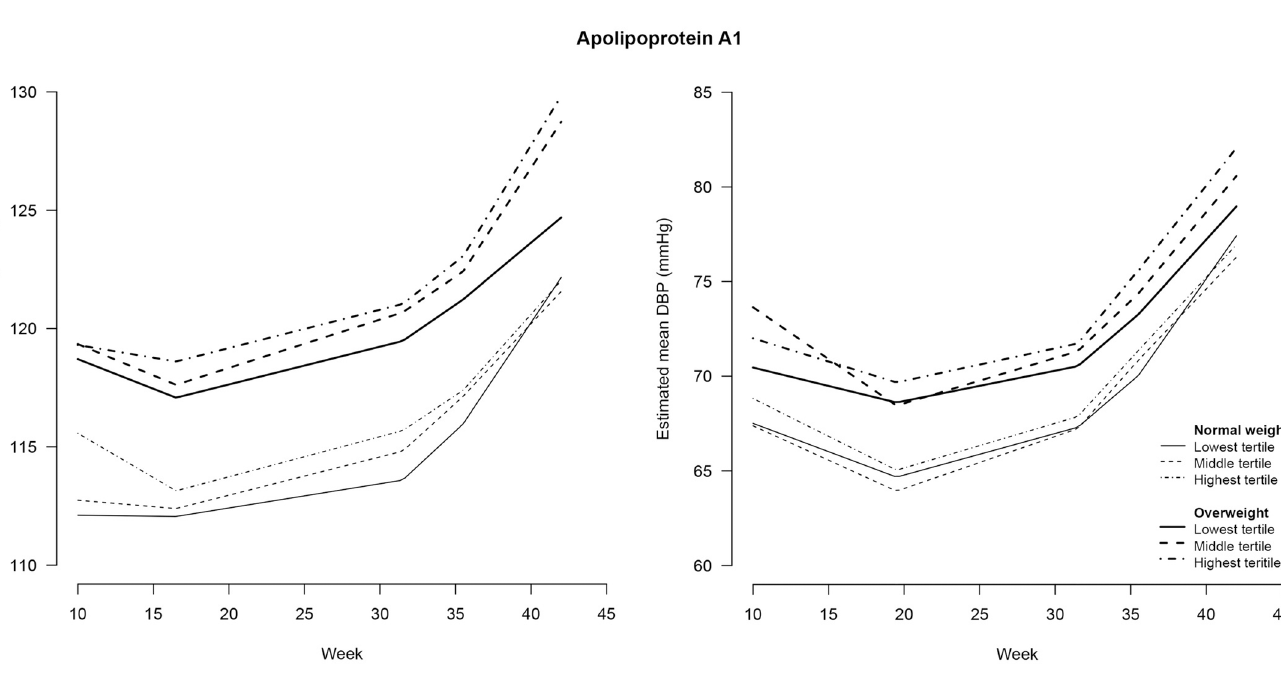
Fig 5. Blood pressure during pregnancy stratified for maternal weight status and tertiles of Apolipoprotein A1 # . SBP = systolic blood pressure; DBP = diastolicblood pressure. # Apolipoprotein A 1 was determined in non-fastingblood samplesdrawn at a medianof 13 (IQR = 12–14)weeks of